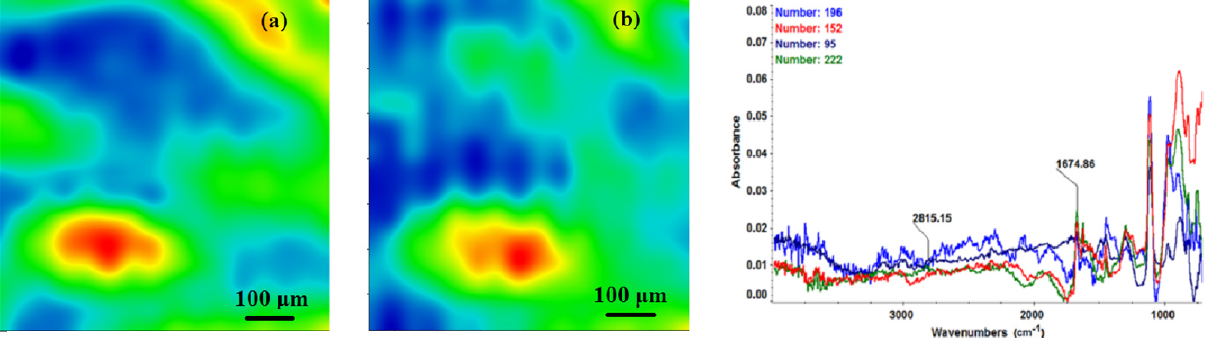
− 1 − 1 and ( b ) 1689 cm